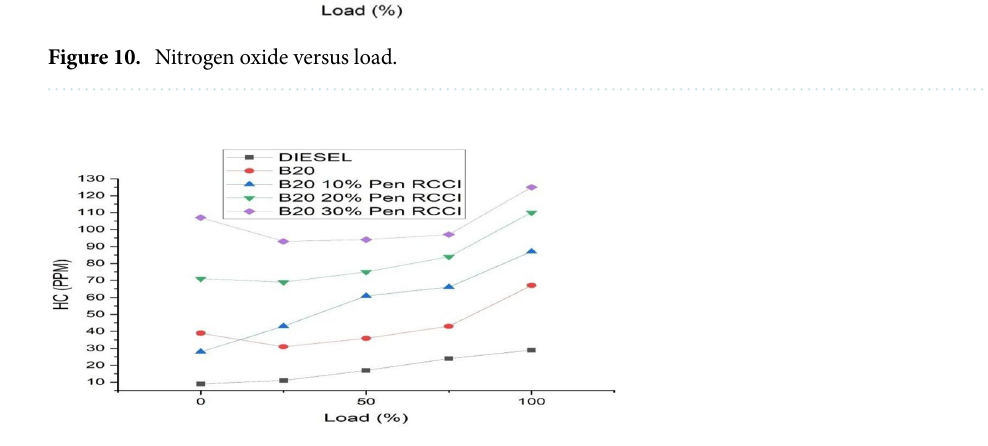
Figure 11. Hydrocarbon emission versus load.